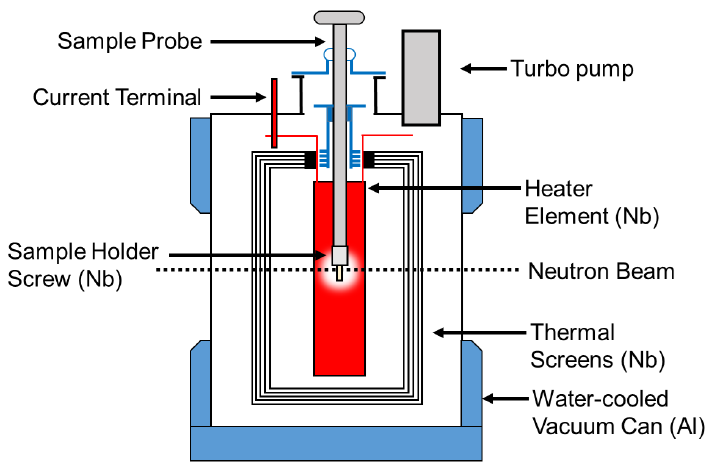
Figure 3. Top loading neutron furnace layout and description of furnace elements. More information pertaining to this furnace can be found in Ref. [24].